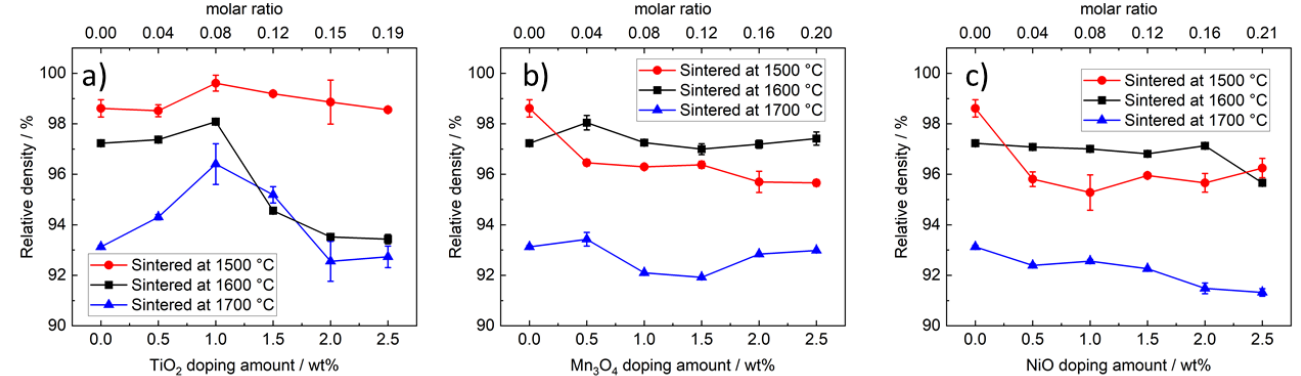
Figure 6. ( a ) Relative density of TiO 2 -doped Na- β″ -alumina samples; ( b ) relative density of Mn 3 O 4 -doped Na- β″ -alumina samples; ( c ) relative density of NiO-doped Na- β″ -alumina samples.